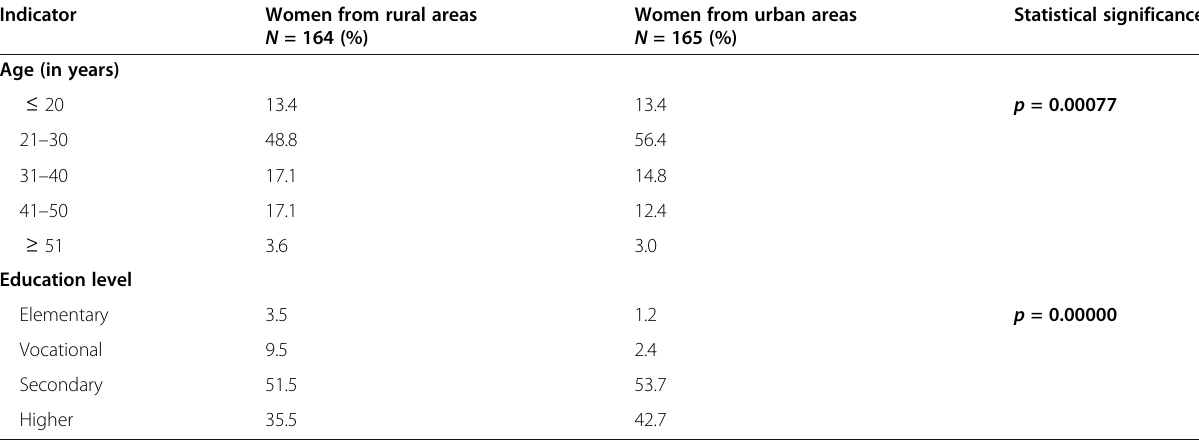
Table 1 The characteristics of the examined population